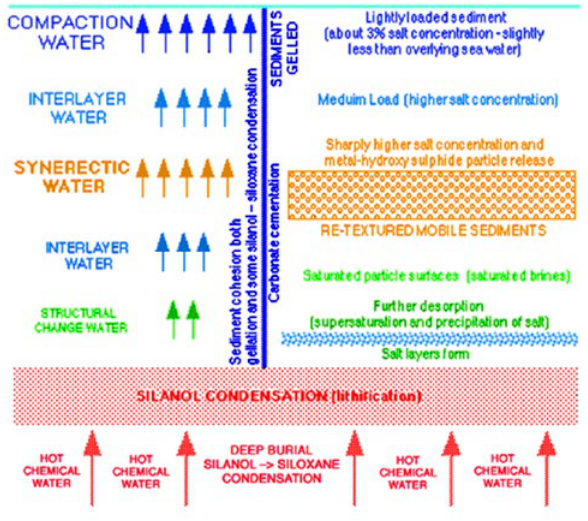
Figure 77. Sediment mobility and porphyroid formation increases ite formation.